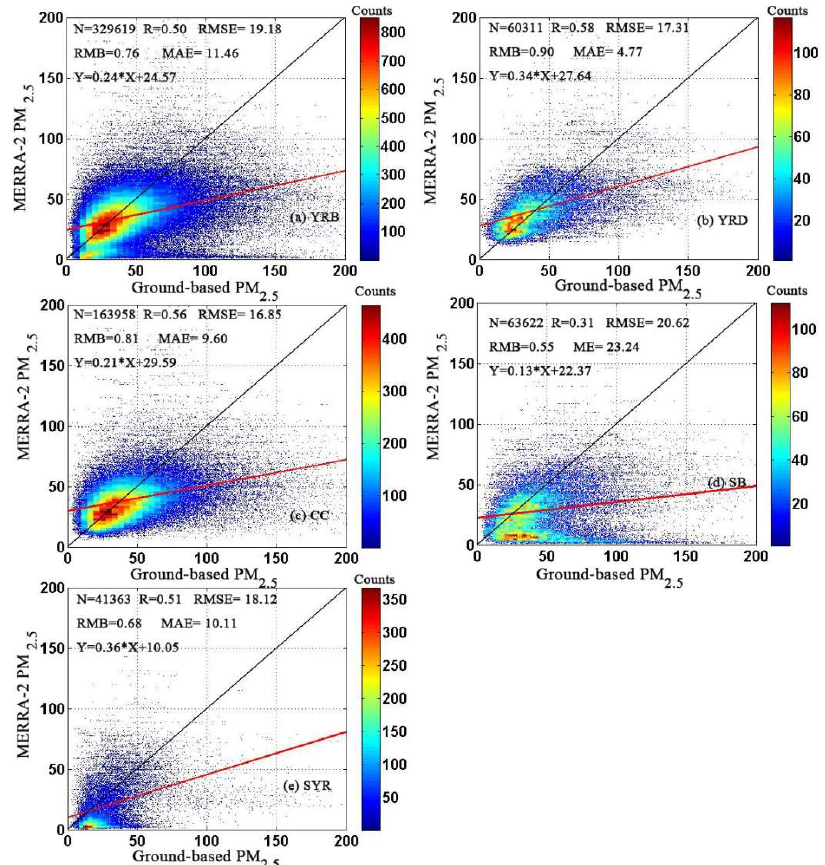
Figure 2. Scatter density maps between MERRA-2 and ground-based daily mean PM 2.5 concentrations over the ( a ) YRB, ( b ) YRD, ( c ) CC, ( d ) SB and ( e ) SYR for the period of Jan. 2015–Dec. 2016. The parameter N represents the number of matchups, R is the correlation coefficient, RMSE is the root mean square error, RMB is relative mean bias and MAE is the mean absolute error. The color bars represent the density of the matchups.